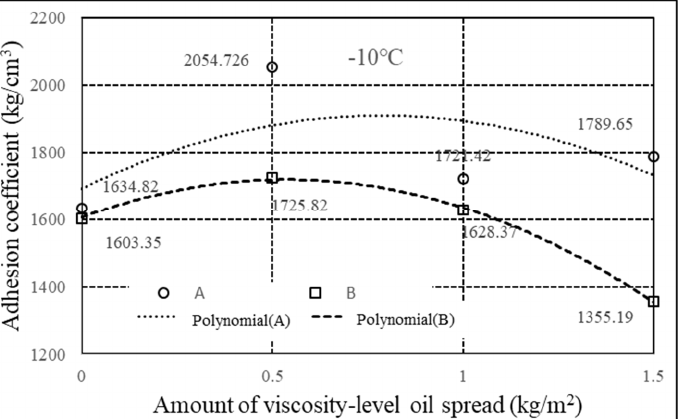
Figure 13. Adhesion coefficient curve of viscosity-level oil A and B specimens at − 10 °C.